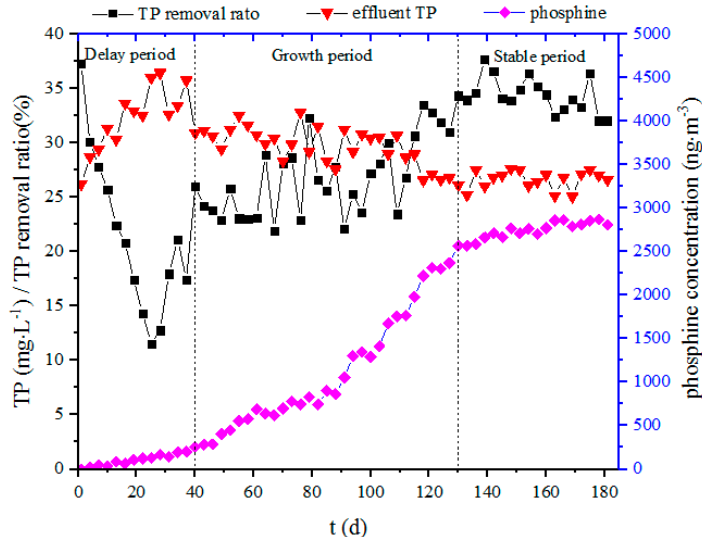
Figure 2. Total phosphorus removal and phosphine production over time.